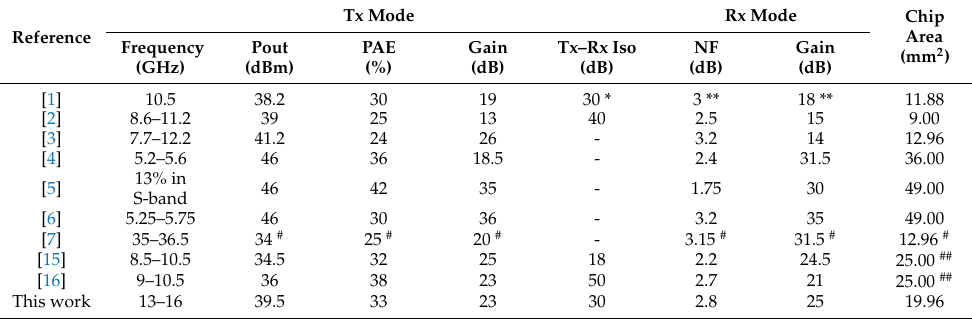
Table 2. Comparison between the presented SCFE and other state-of-the-art